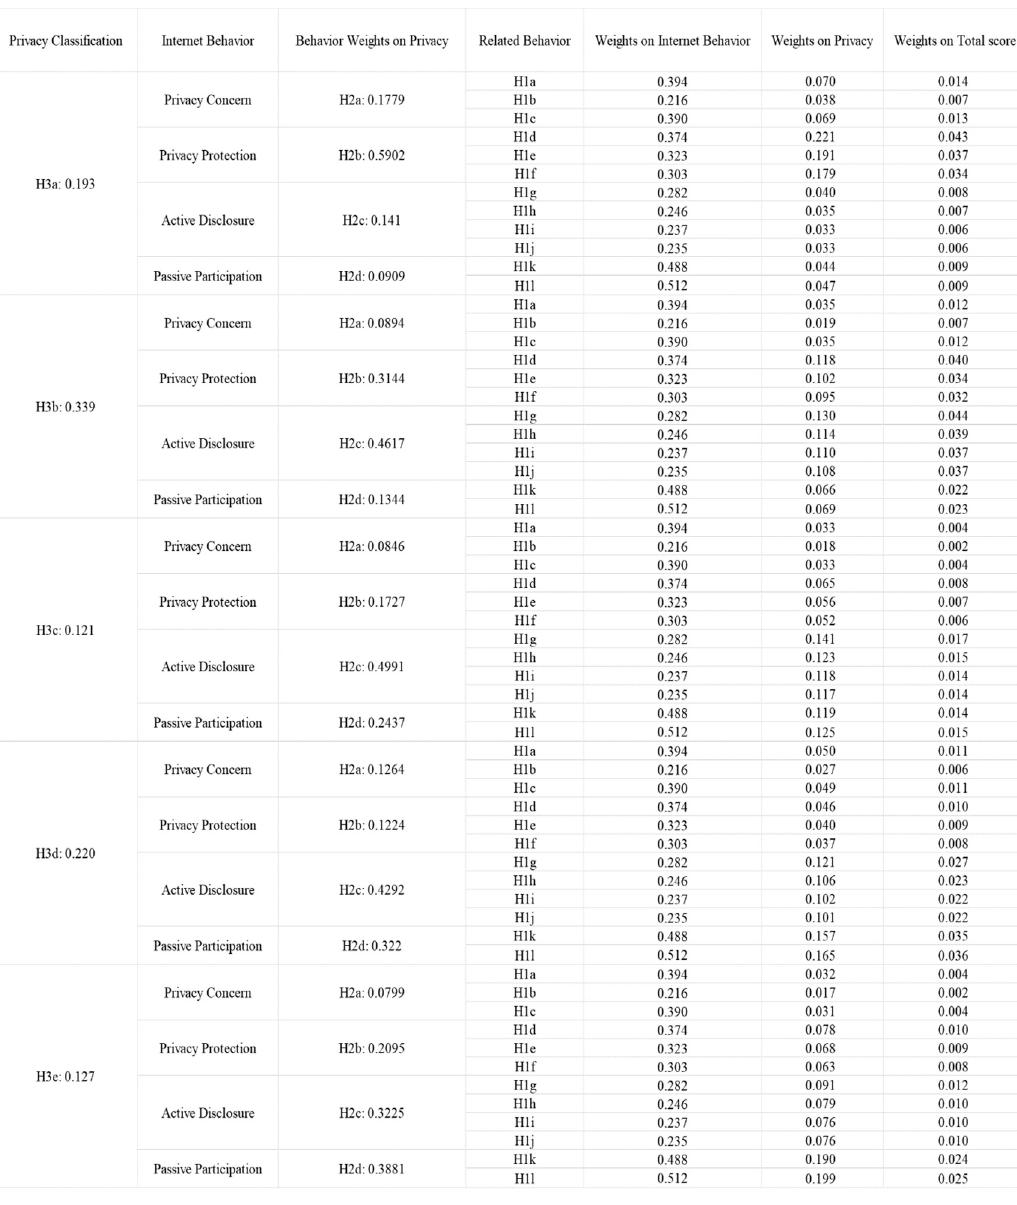
Figure 7. Model analysis